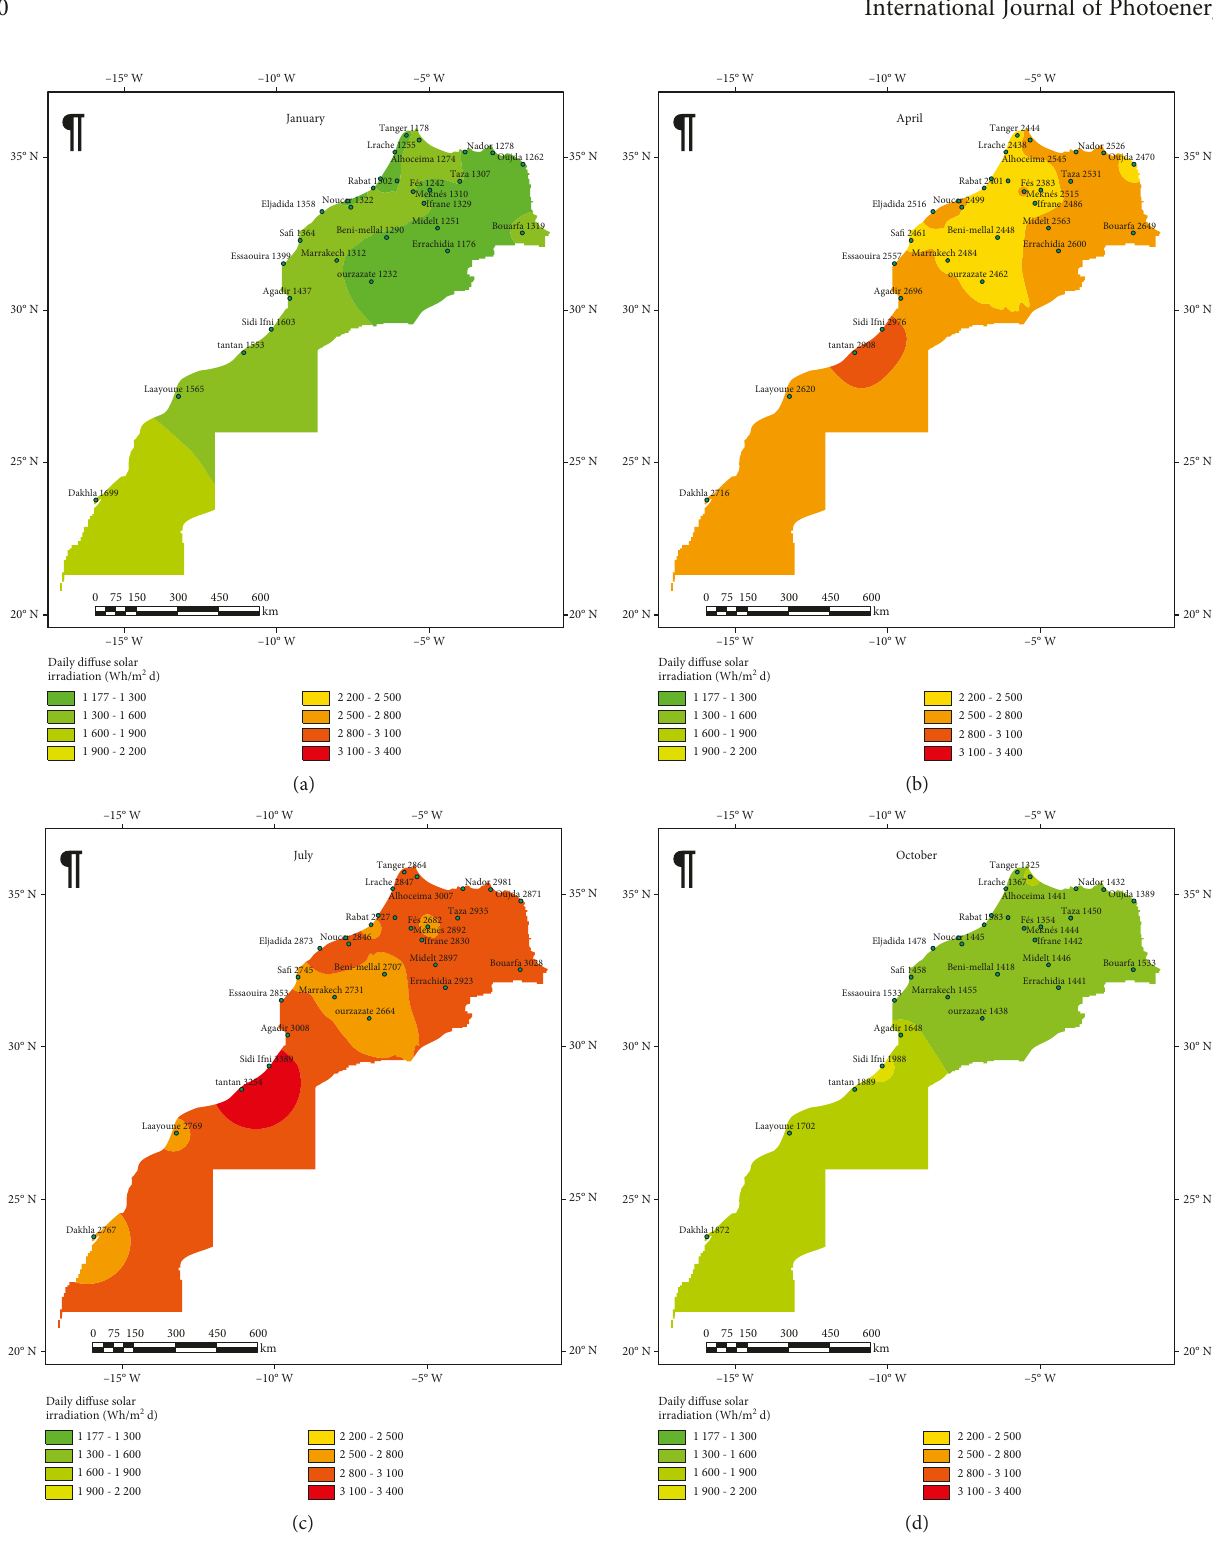
Figure 7: Maps of the monthly average values of daily di ff use irradiations on a horizontal incident plane in Morocco. Maps of di ff use solar radiation on a horizontal plane (a –